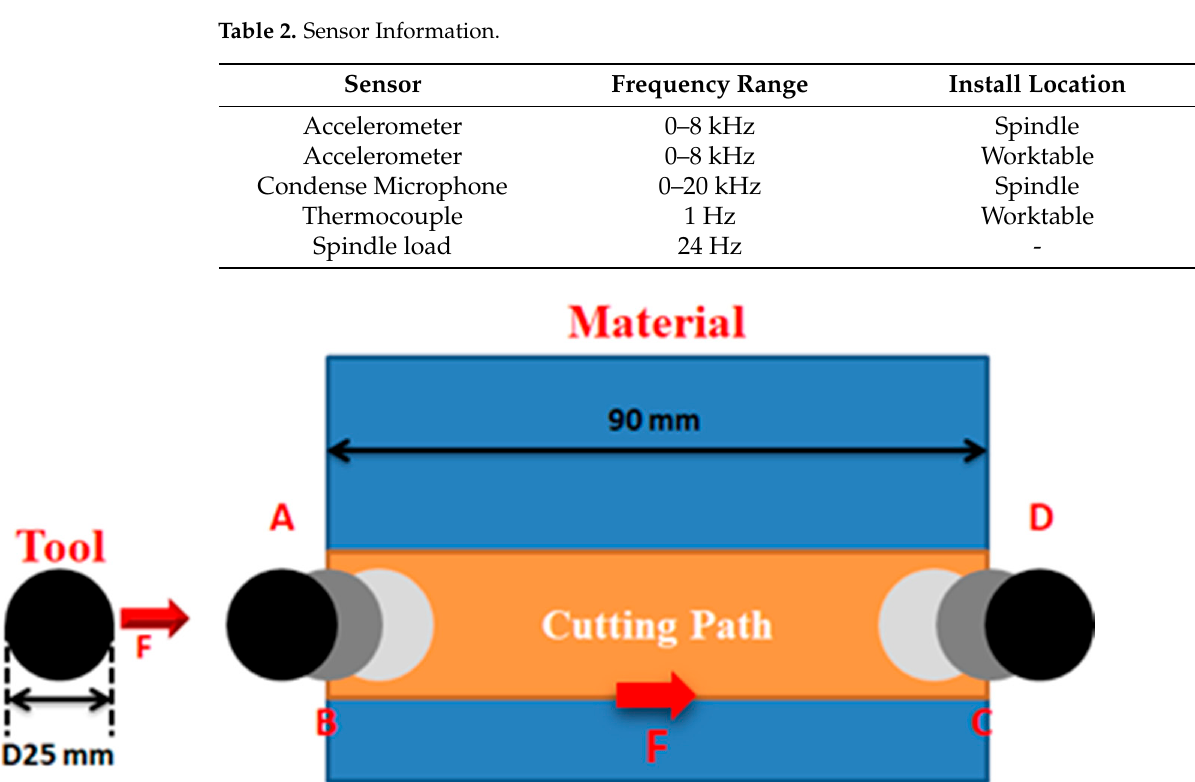
Figure 2. Milling Path Illustration. Table 1. Experimental Cutting Parameters.